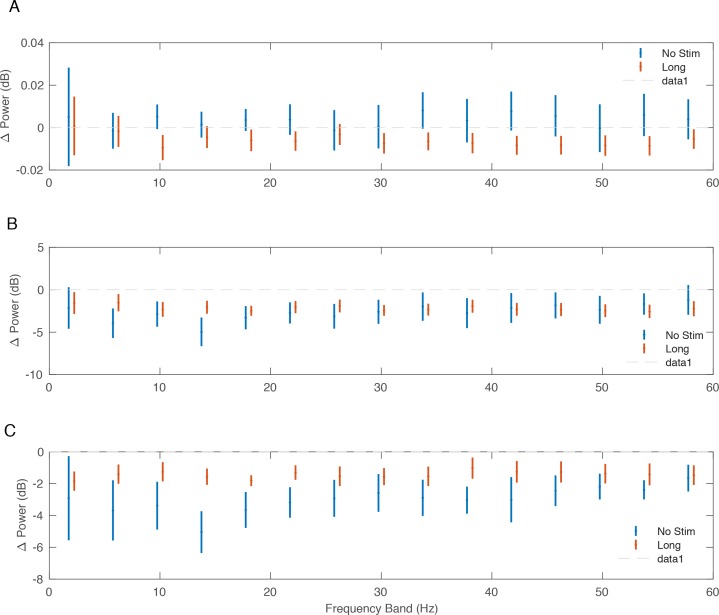
Change in power following stimulation.Change in power from pre- to post-conditioning across monkeys and non-interference experiments. Bars reflect standard errors around the mean change in power in each 4 Hz frequency band. (A) Average change in power across secondary recording sites normalized to the change in power at the stimulation site. (B) Average change in power across secondary recording sites. (C) Average change in power at the stimulation site.10.7554/eLife.31034.014Figure 4—figure supplement 2—source code 1.Comparison of power measurements between control and stimulation data across different frequency bands.10.7554/eLife.31034.015Figure 4—figure supplement 2—source data 1.Power measurementsacross different frequency bands for each session.